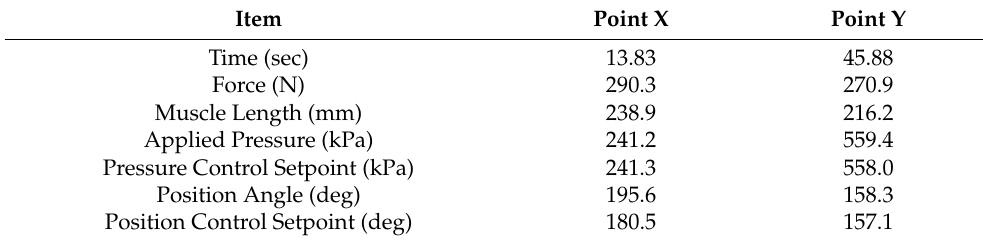
Figure 21. Control system response during NARX activation–deactivation transitions at 0.25 Hz sinusoidal position trajectory. Table 5. Numerical values for critical points marked in Figure 21.